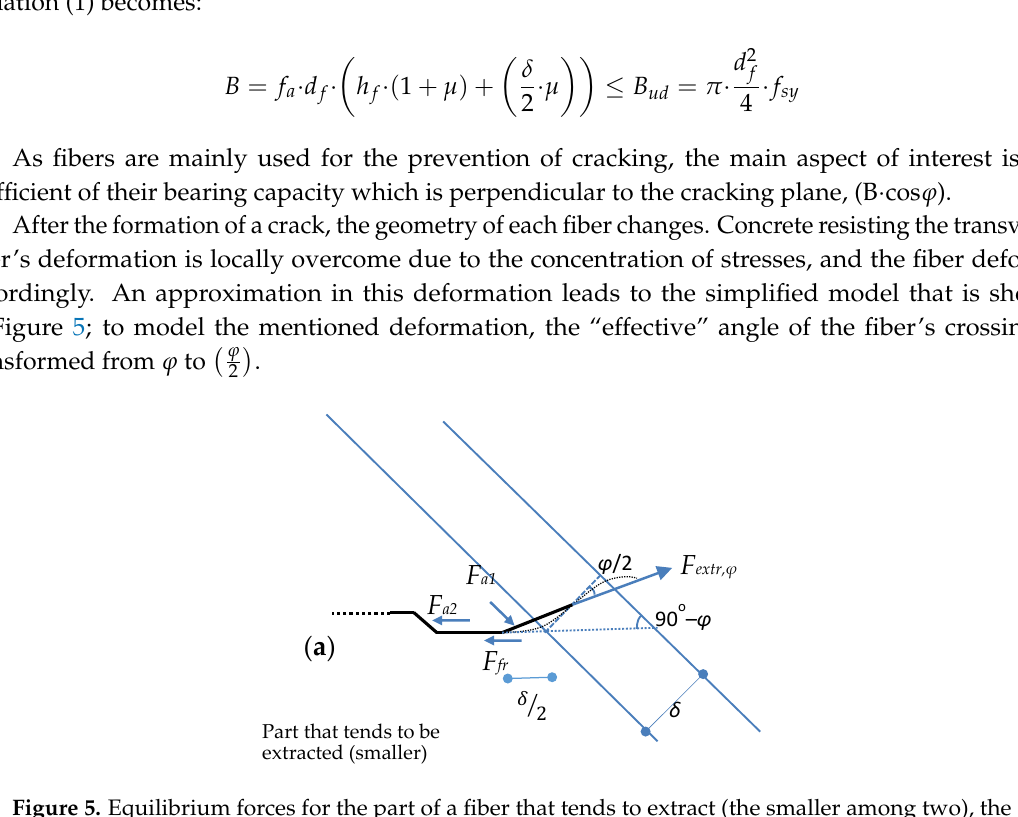
Figure 5. Equilibrium forces for the part of a fiber that tends to extract (the smaller among two), the dotted line ( a ) symbolizes the beginning of the extraction.